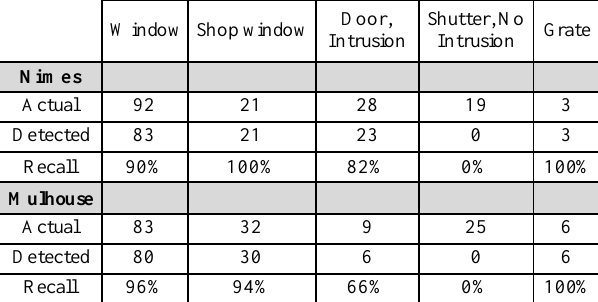
Table 3: Pixel-based evaluation with confusion matrix Large-scale results. The detection method has been processed on the Nimes and Mulhouse datasets with acquisition distance 10Km and 3Km respectively. Table 4 describes these data and the detection results. The number of buildings corresponds only to those scanned by the LIDAR. The processing time corresponds to the detection process with a desktop computer 8 core processor 32 GO RAM. The processing time does not include the manual registration or the texturation process.